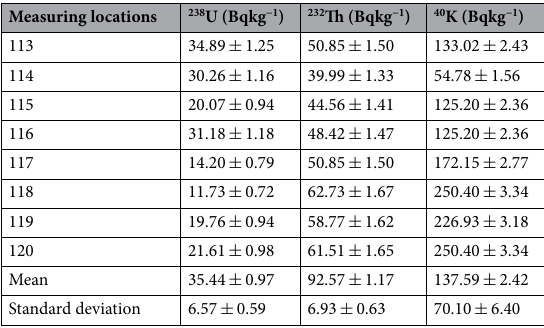
Table 1. The measurement of 238 U, 232 Th and 40 K radioactivity surface rock at the study area.